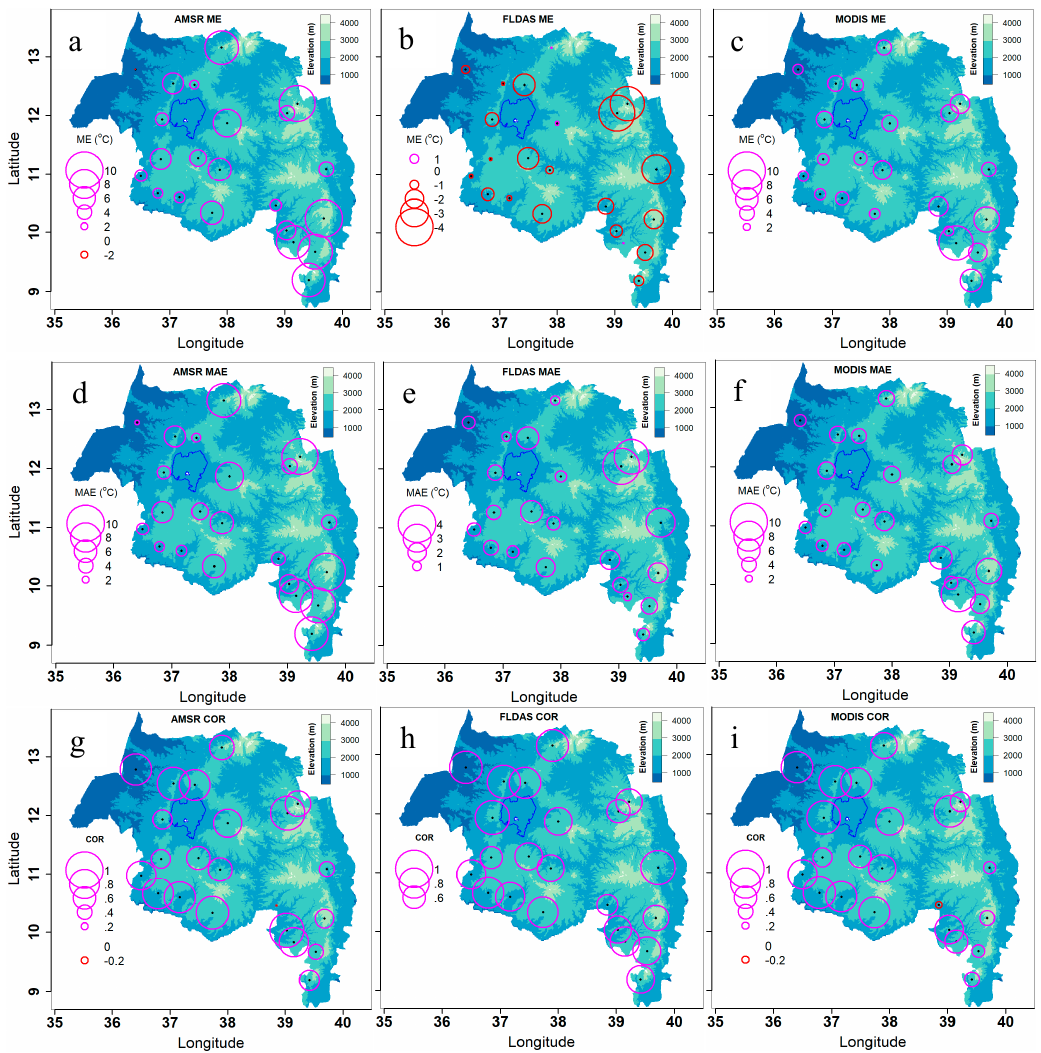
Figure 10. Pixel-level satellite/interpolated daily temperature data accuracy statistics spatial distribution for 22 meteorological stations in Amhara Region, Ethiopia for 2003–2016. Note the legend-scale differences.